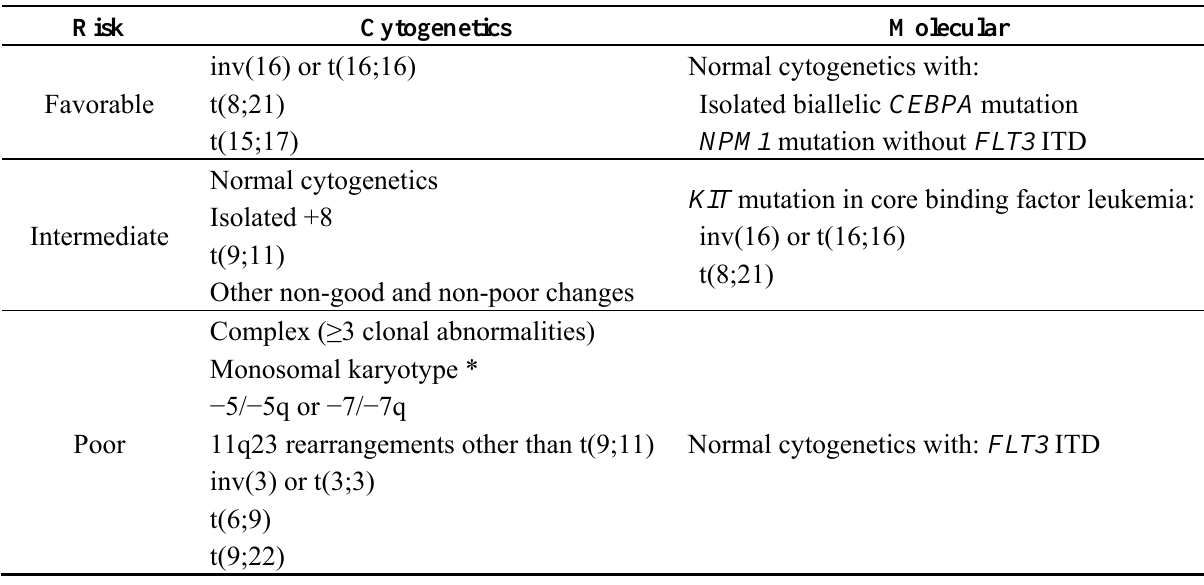
Table 2. Cytogenetic and molecular findings used in risk stratification for